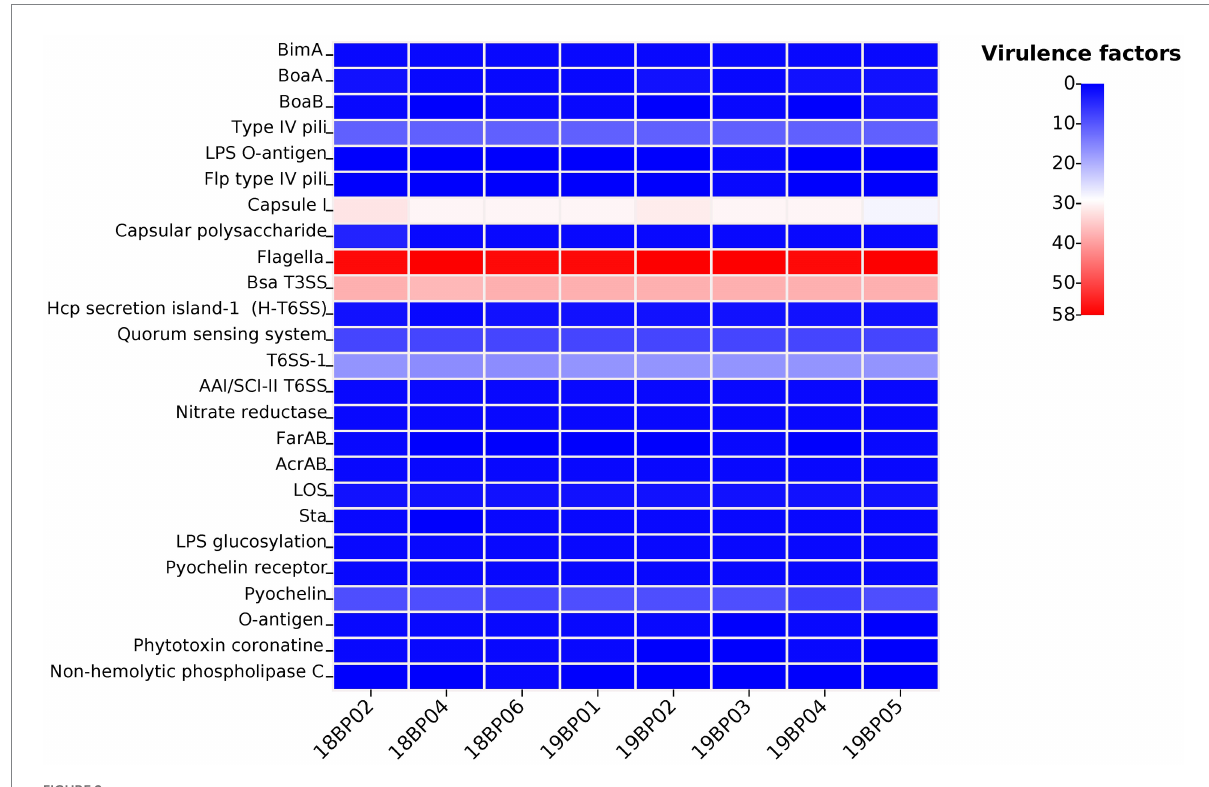
FIGURE 2 Heat map displaying virulence genes distribution in the eight B. pseudomallei strains. Each isolate has a different number of virulence factors ( n =